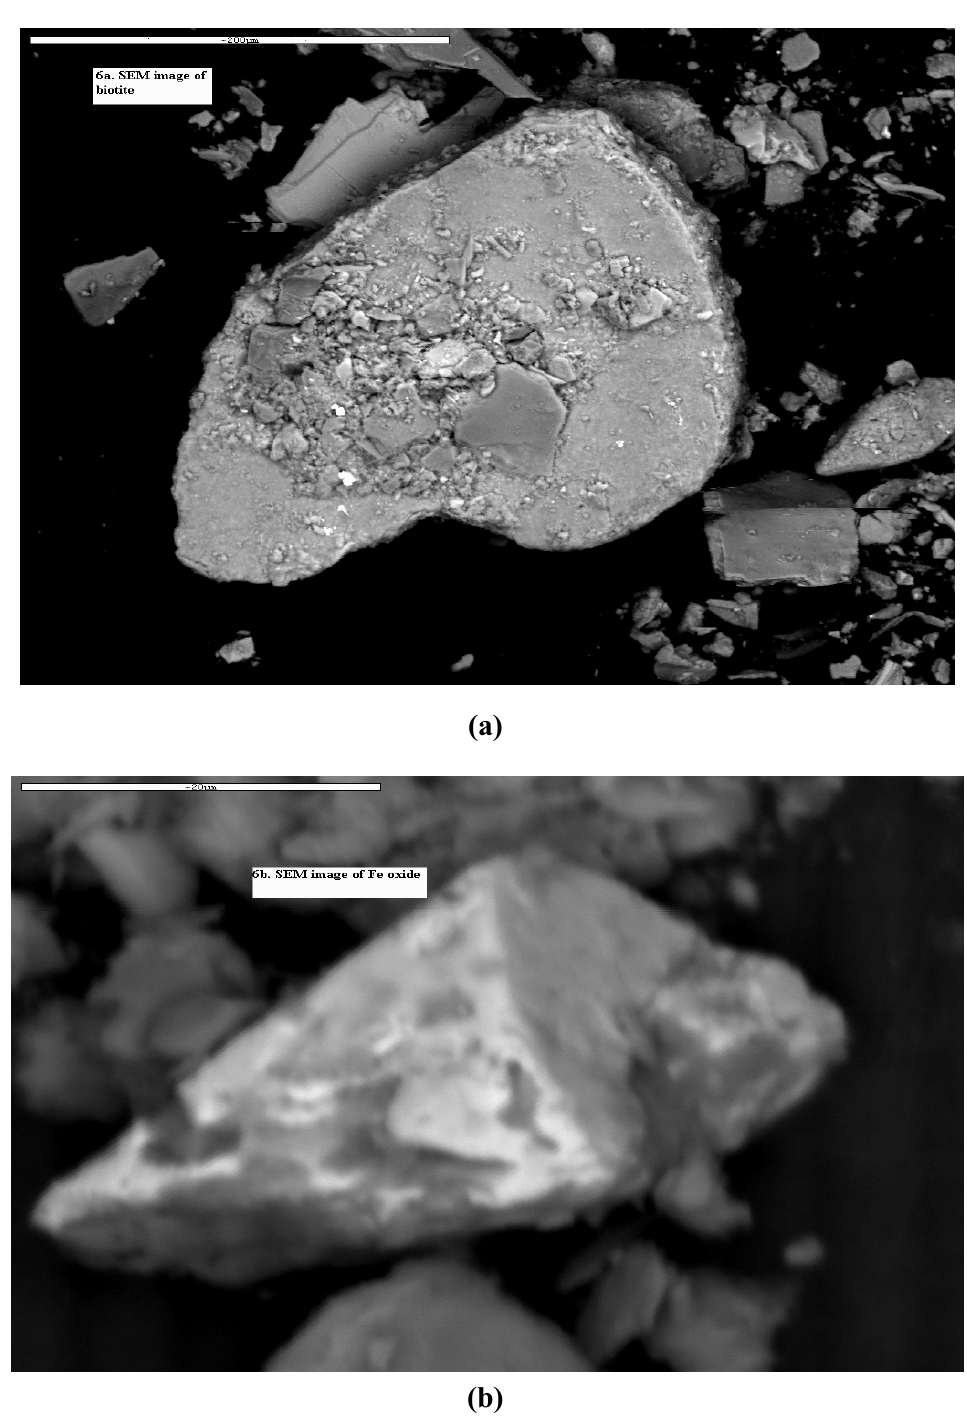
Figure 6. SEM image of ( a ) biotite, ( b ) and ( c ) Fe oxyhydroxide in sediments of